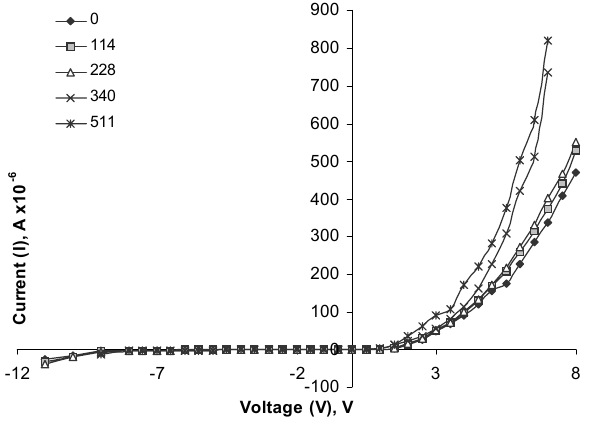
Figure 3. Full-scale I-V plots of as-printed and γ -irradiated at different doses NiO/Si pn- junctions.